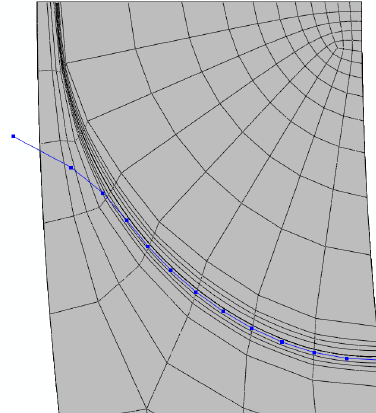
Figure 19: Spline (blue line) used to create through-the-wall